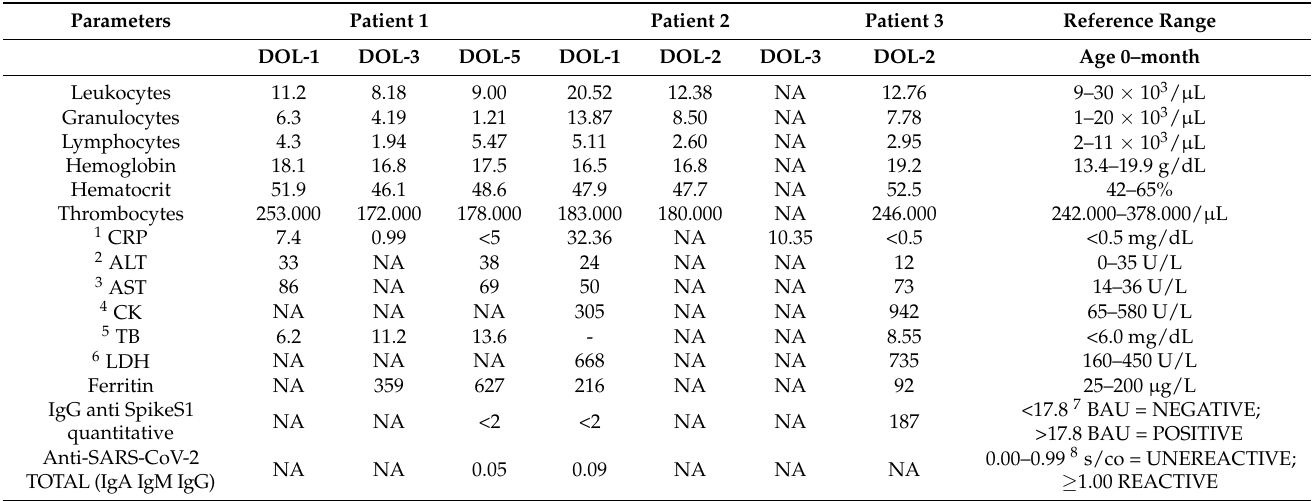
Table 3. Laboratory tests during